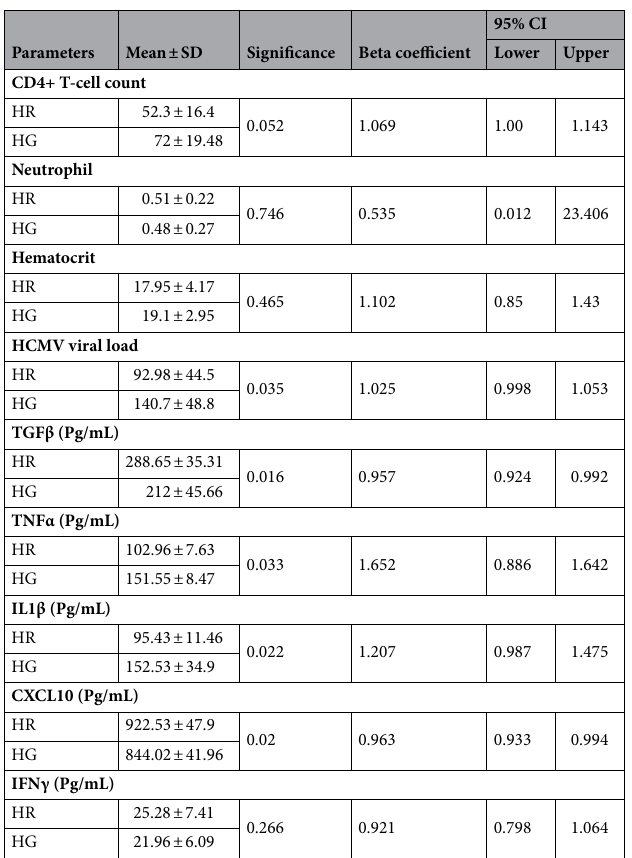
and HCMV induced Gastroenteric disease (HG; N = 11) cases among HIV infected Group 1